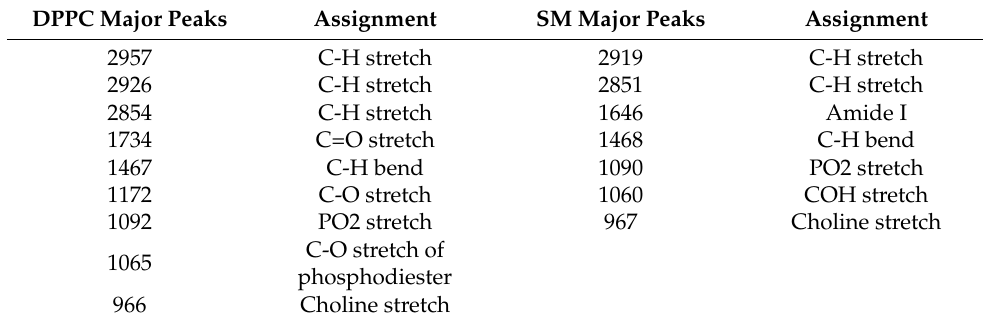
Table 1. Peak Assignments for DPPC and SM.